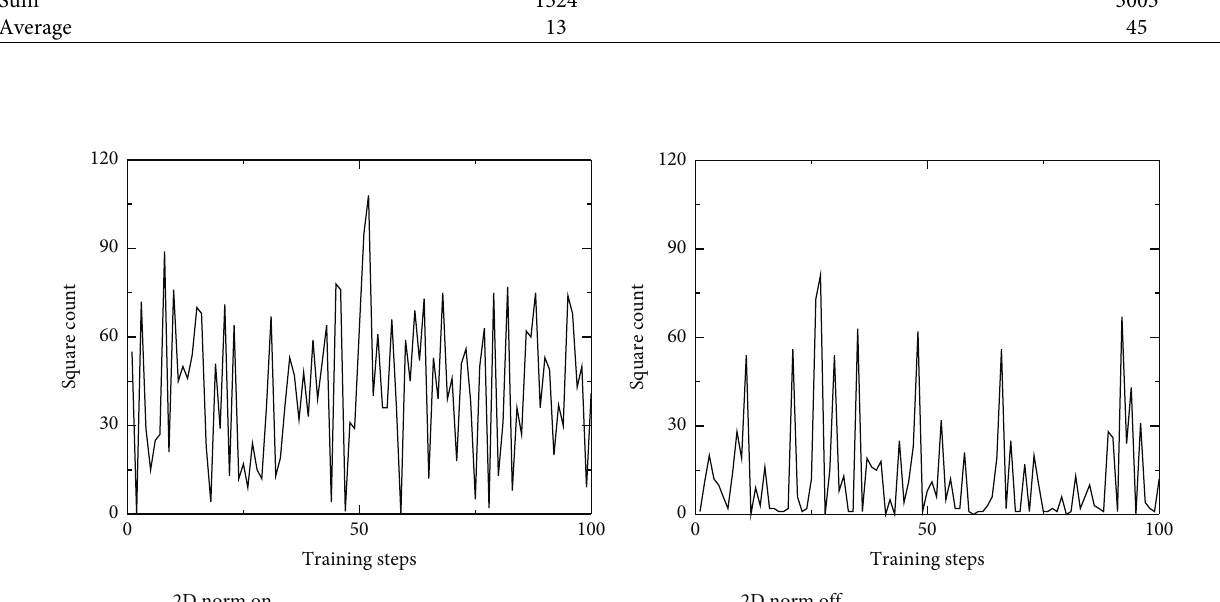
Figure 6: Comparison of the number of squares with or without 2D normal